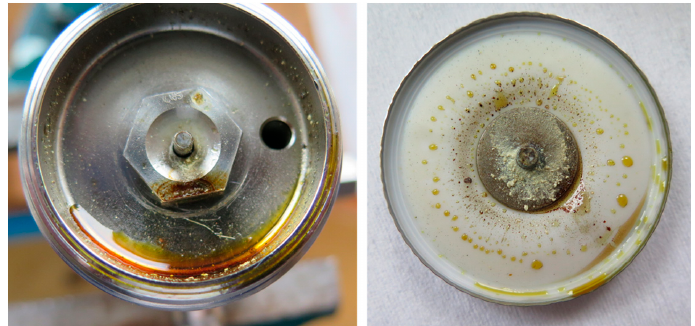
Figure 6. Pictures showing products that have precipitated and accumulated inside the heated gas regulator body ( left ) and on the regulator’s diaphragm ( right ).